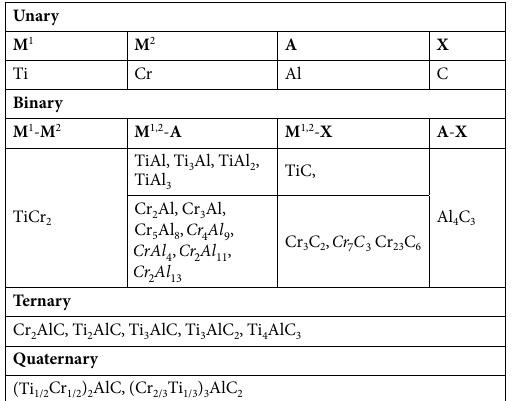
Table 1. List of considered competing unary, binary, ternary, and quaternary intermetallic